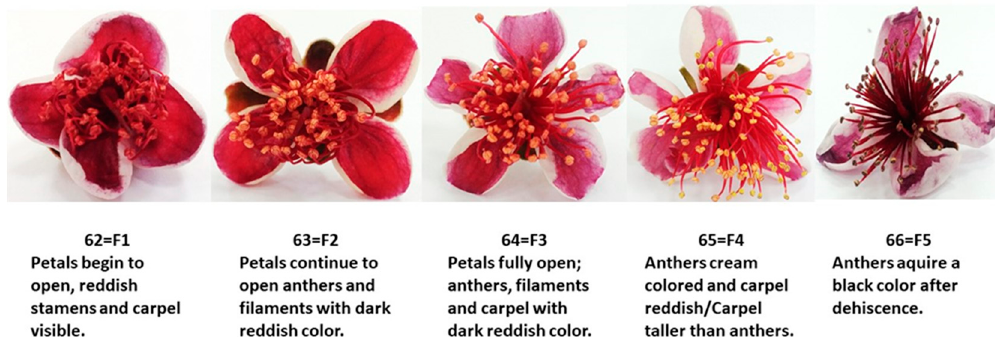
Figure 1. Di ff erent flowering stages of feijoa flowers. Petals begin to open: Reddish stamens and carpel Figure 1. Different flowering stages of feijoa flowers. Petals begin to open: reddish stamens and carpel visible—F1; petals continue to open: Anthers and filaments with dark reddish color—F2; petals fully open: Anthers, filaments, and carpel with dark reddish color—F3; anthers cream-colored and carpel visible—F1; petals continue to open: anthers and filaments with dark reddish color—F2; petals fully reddish / Carpel taller than anthers—F4; anthers acquire a black color after